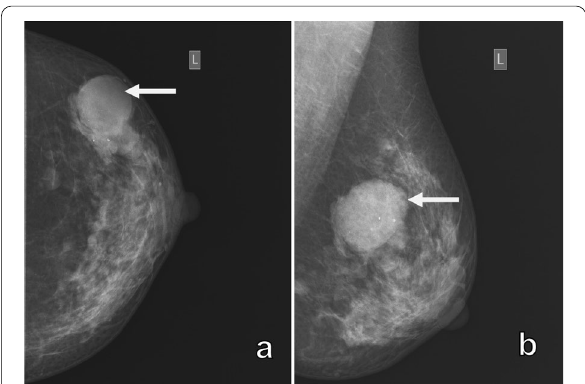
Fig. 1 Mediolateral oblique ( a ) and craniocaudal ( b ) mammography of the breast showing high-density oval circumscribed mass on upper outer quadrant of left breast with few small rounded calcifications associated within